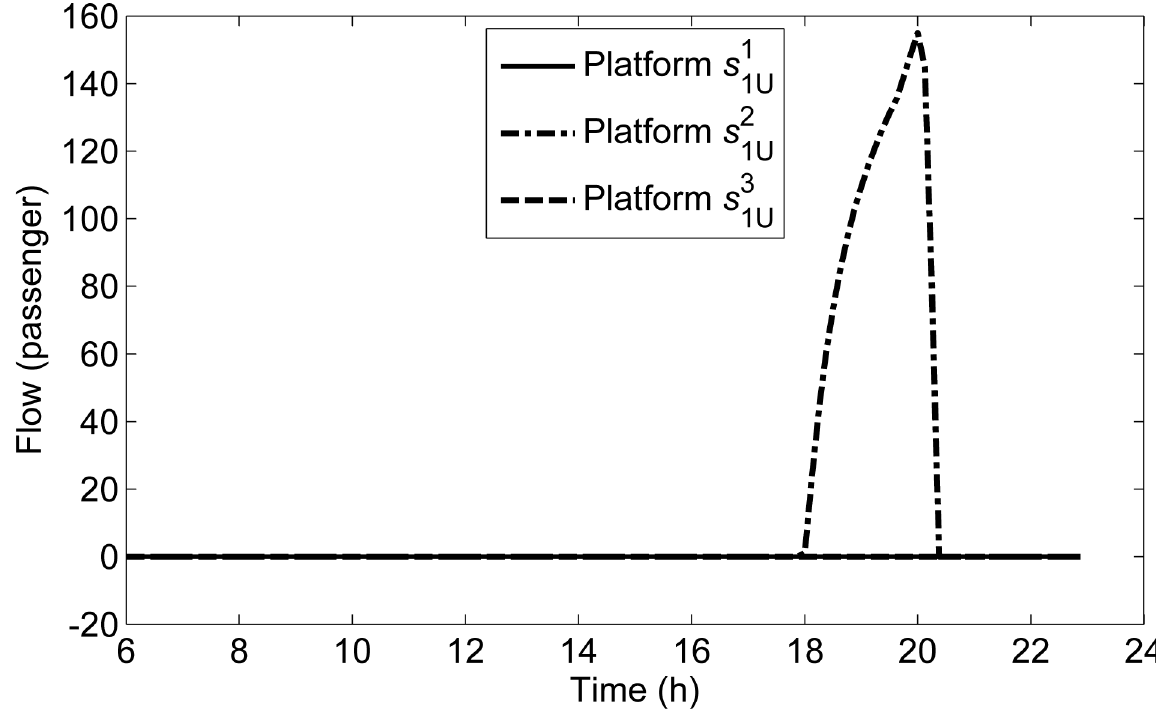
Fig 7. The detained flows of all platforms along L 1U .